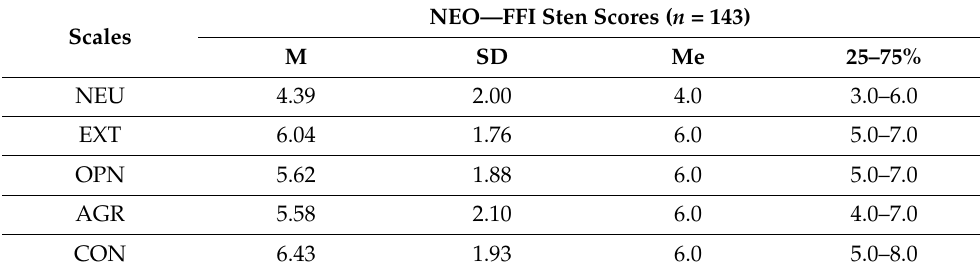
Table 2. NEO-FFI results in sten